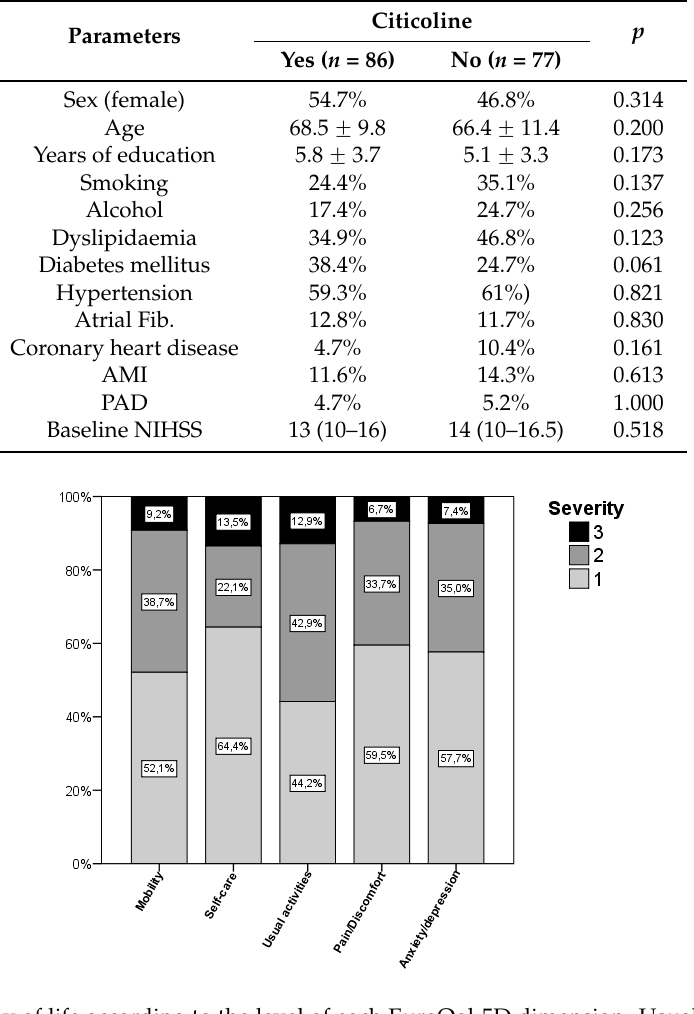
Figure 1. Quality of life according to the level of each EuroQol-5D dimension. Usual activities was affected in a higher number of patients.